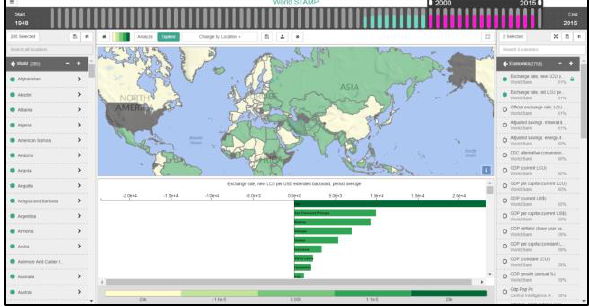
Figure 6. Current WSTAMP tool interface